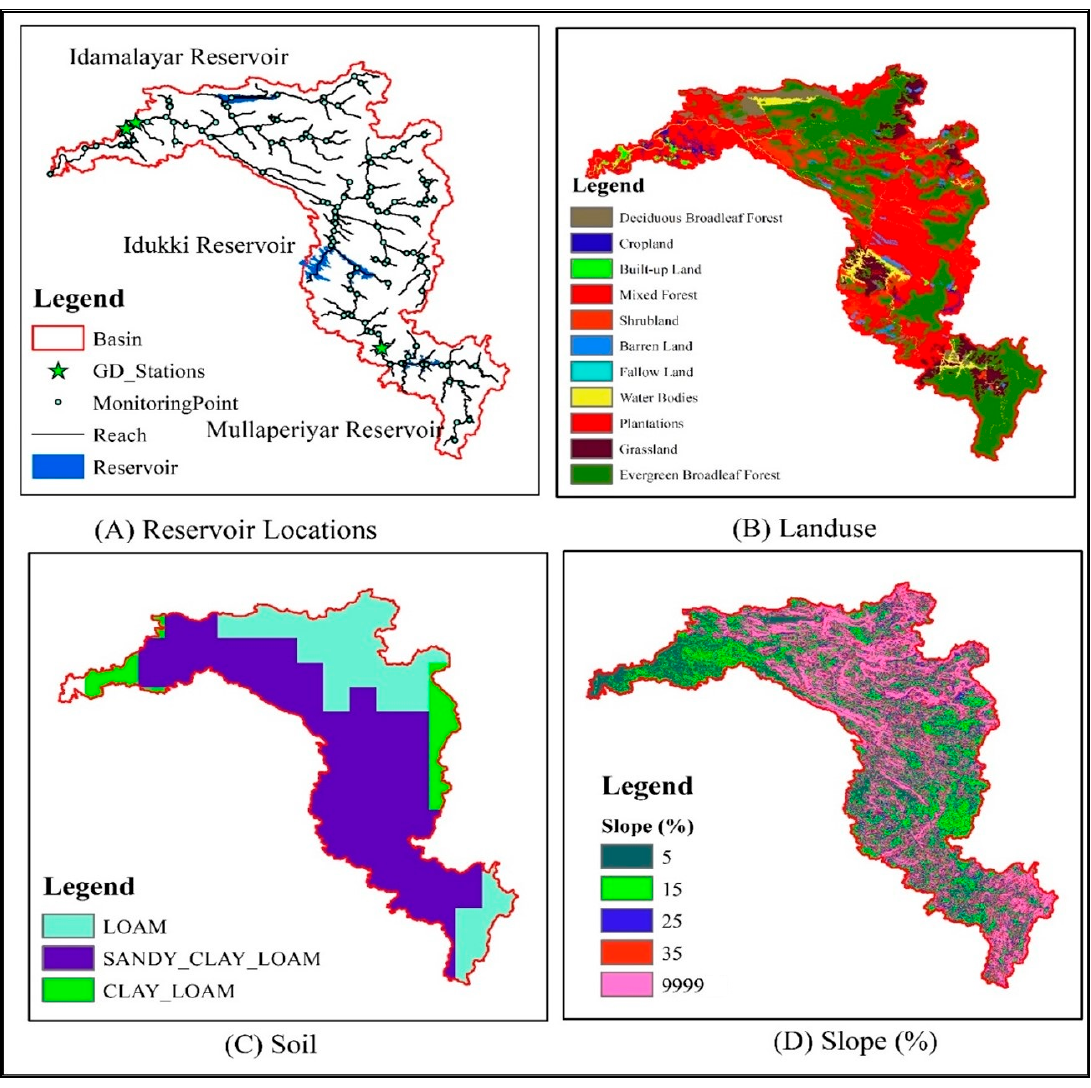
Figure 3. Periyar river basin where river reaches, reservoirs location, and gauging stations is shown in ( A ), Land use ( B ), Soil ( C ), and Slope ( D